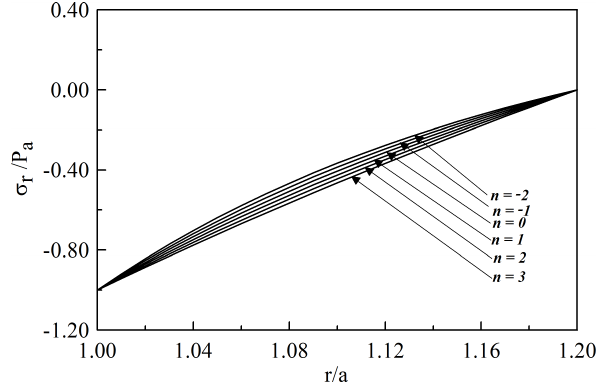
Figure 13: Radially distributed radial stress